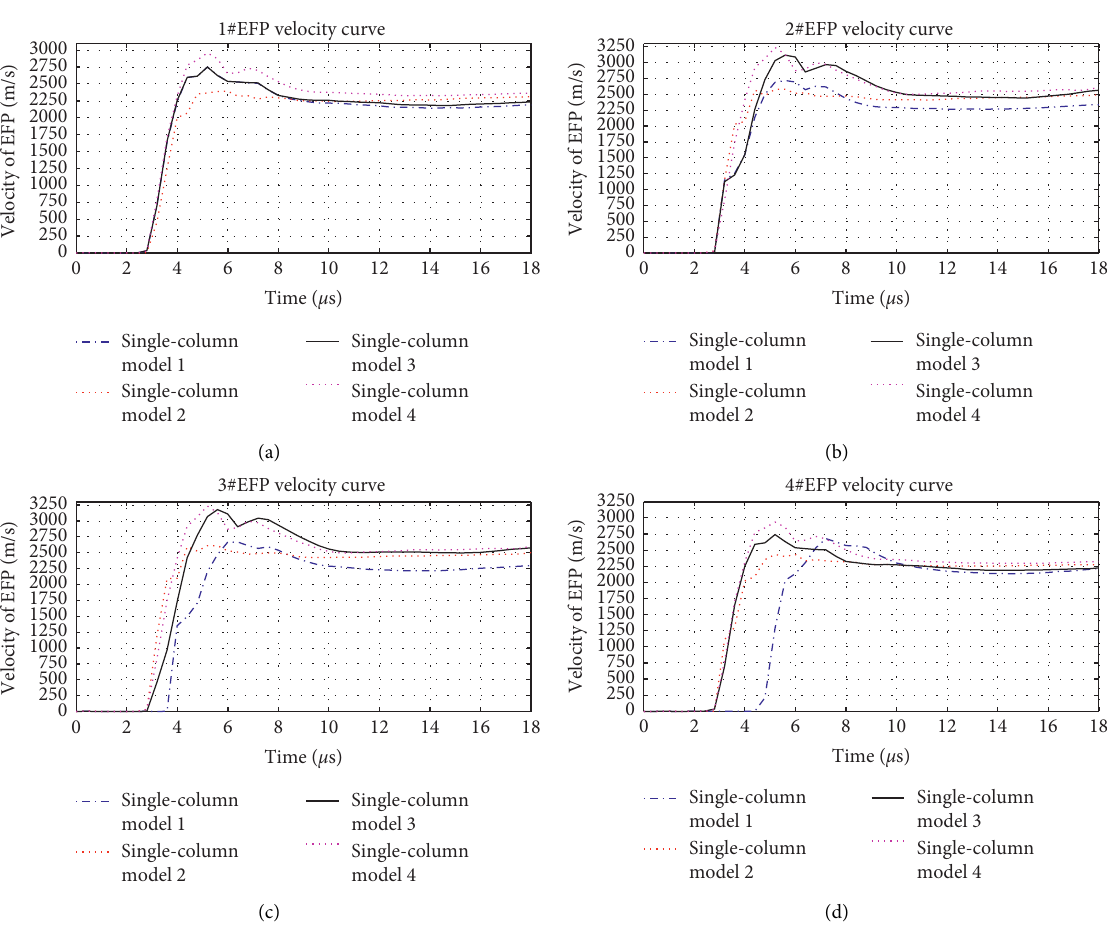
Figure 10: Forming velocity comparison of single-column eccentric initiation.